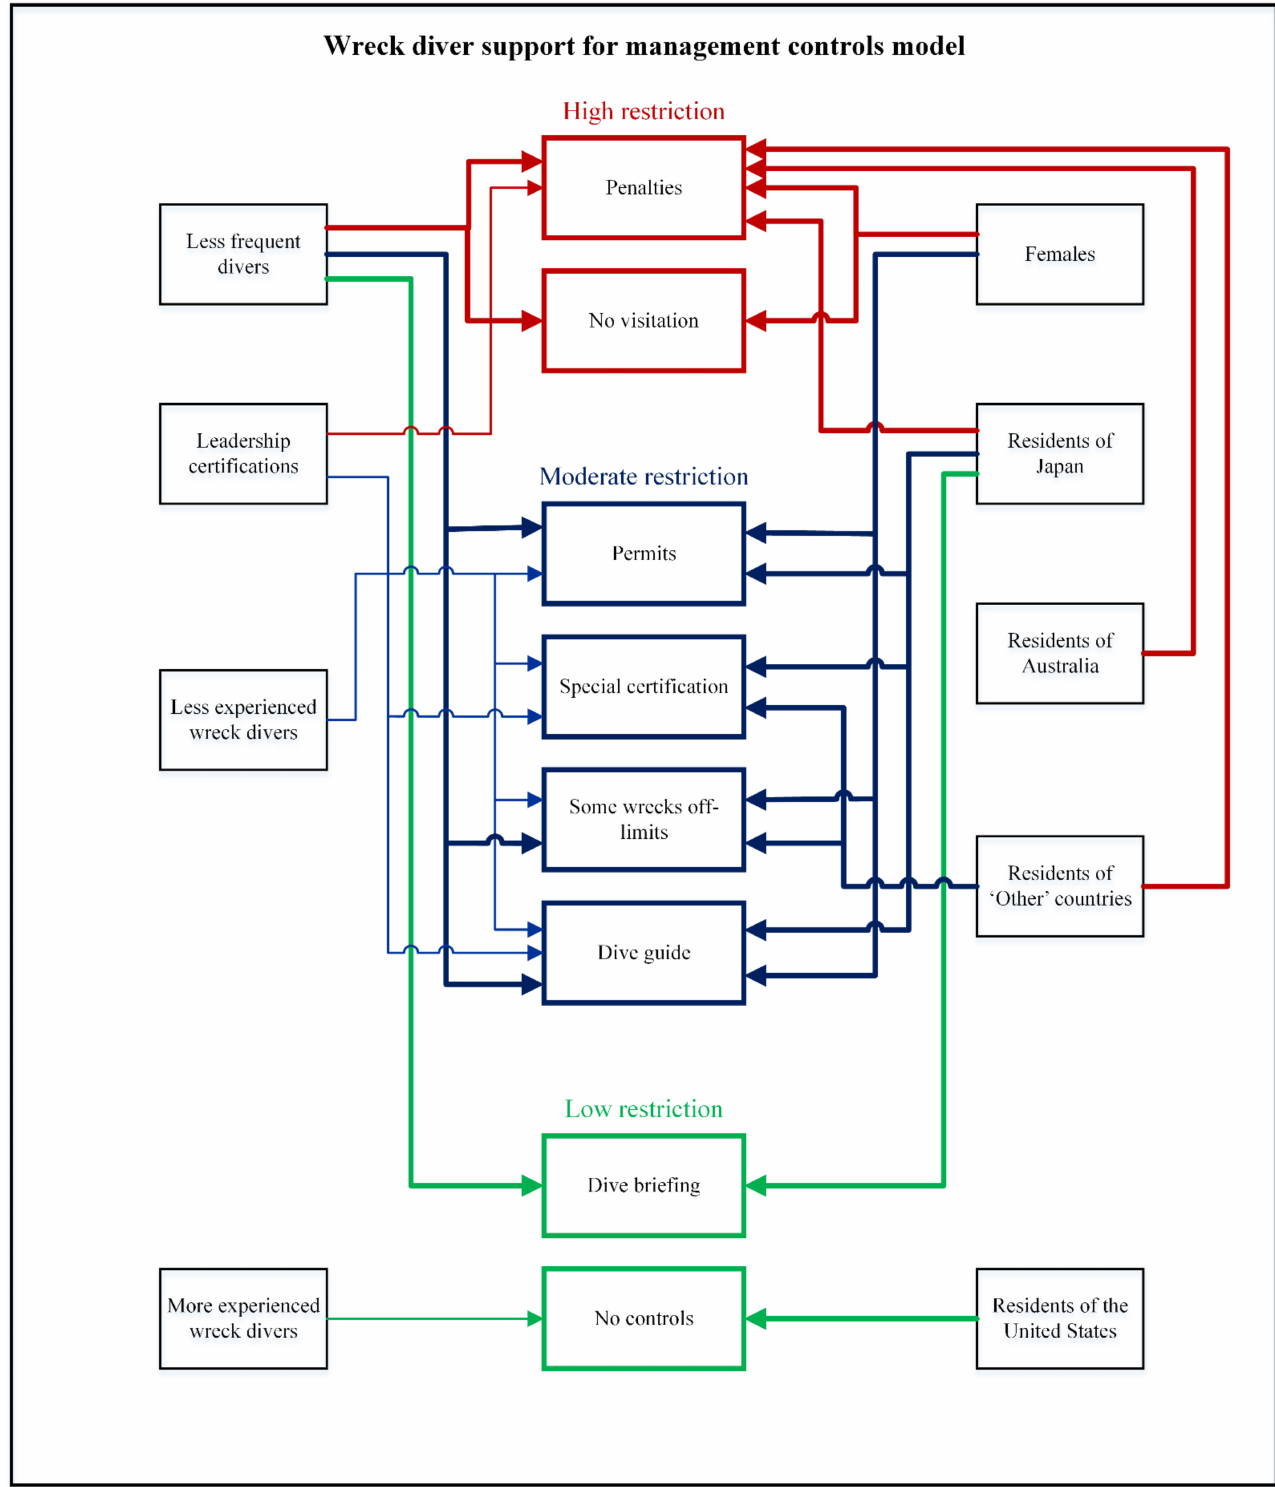
Figure 10. Wreck Diver Support for Management Controls Model—adapted from [37] (p. 353). The relationships between wreck diver profile variables and their support for manage- ment controls, illustrated in the Wreck Diver Support for Management Controls Model, are synthesized in Figure 11, which illustrates the links between the three clusters of manage- ment controls and diver profile variables that predicate stronger support. The strength